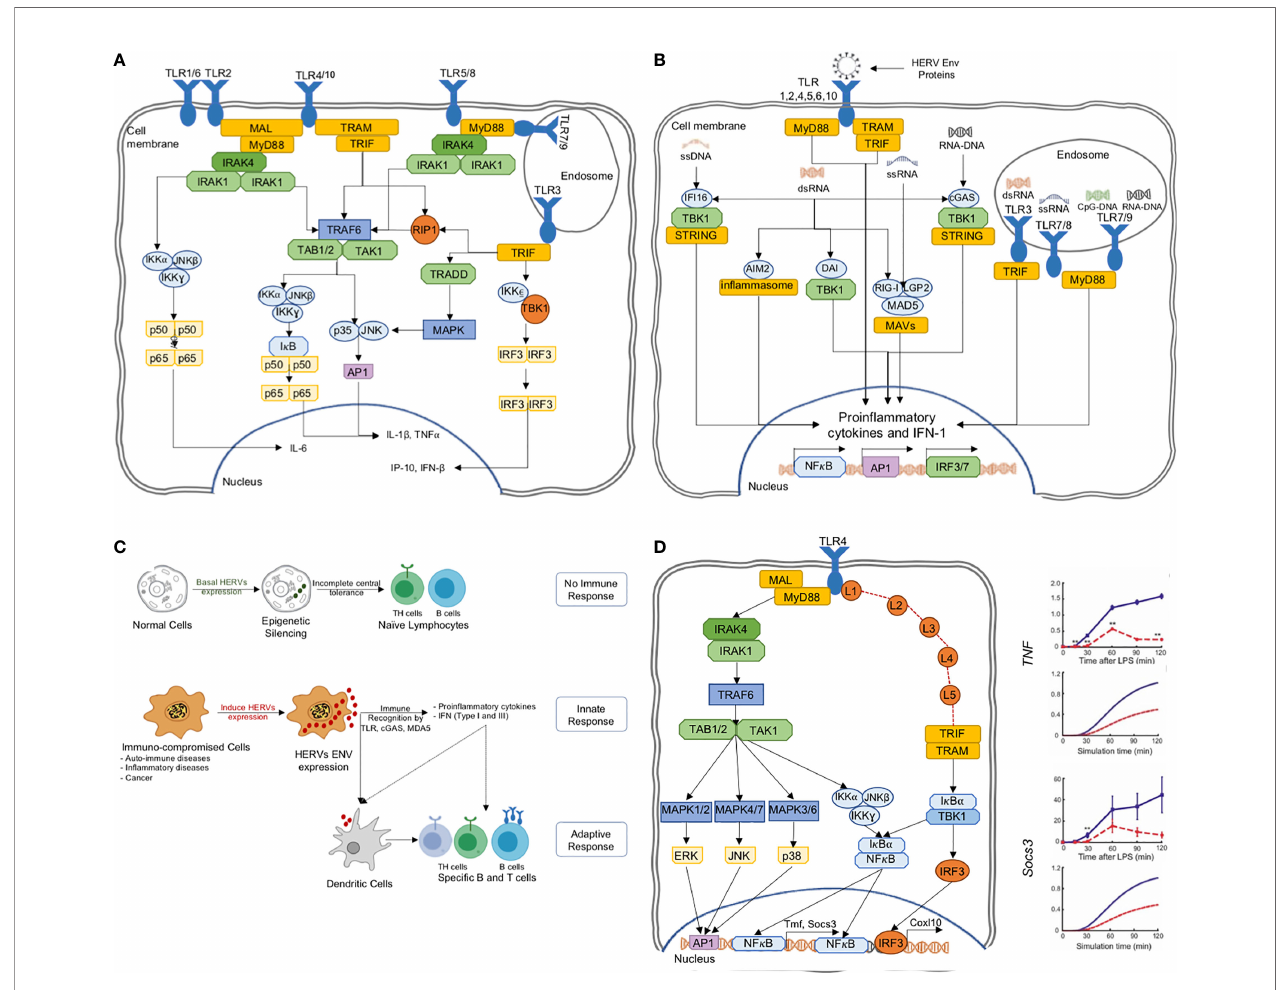
FIGURE 3 | (A) The TLR pathways in human triggering the proin fl ammatory signal transduction, (B) TLRs are able to recognize several HERV ENV proteins to activate the proin fl ammatory responses, (C) HERV ENV proteins are able to stimulate adaptive immune response through T cell differentiation and antigen presentation, (D) TLR models can predict experimentally veri fi able novel intermediates, which could be targeted for controlled proin fl ammatory regulation (42 –